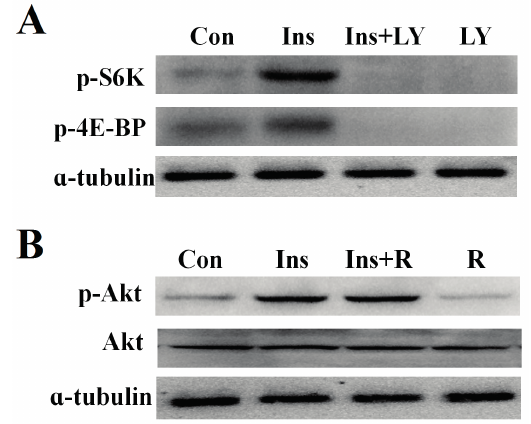
Figure 4. The relationship of PI3K and TOR signaling in silk gland cells. ( A ) Effects of insulin-stimulated S6K and 4E-BP phosphorylation by LY294002; and ( B ) Effects